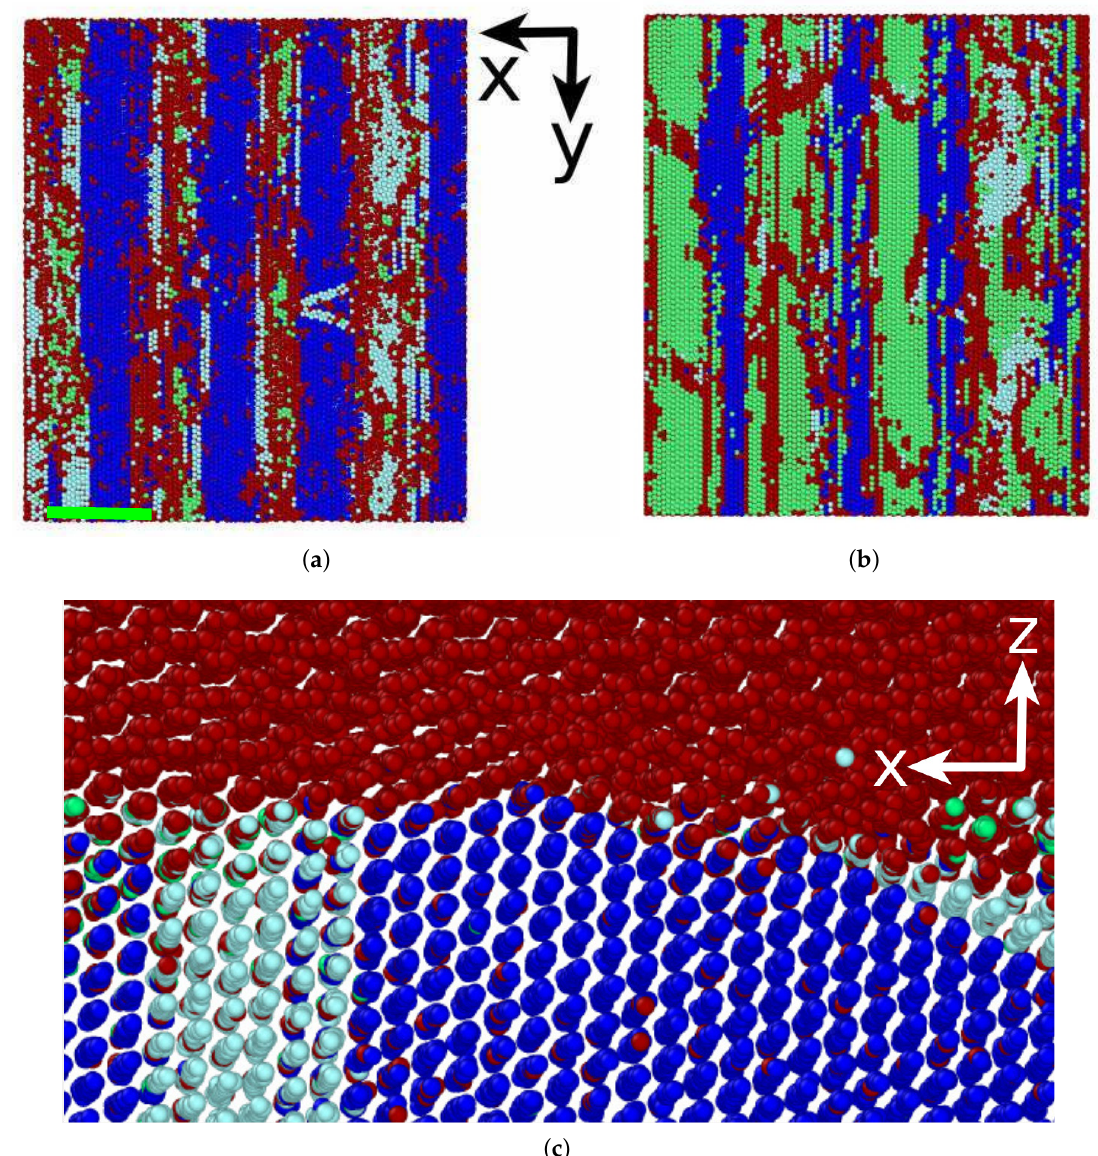
Figure 4. Top view—from the cementite side—of the Pitsch–Petch interface ( a ) before (at 400 K) and ( b ) after (at 1 K) the martensitic transformation. Only the Fe atoms on the iron side of the interface are shown. ( c ) A side view of the interface at 400 K, before the martensitic transformation. The cross section is located at the green line in ( a ) and has a width of 7 nm. Atoms are colored as in Figure